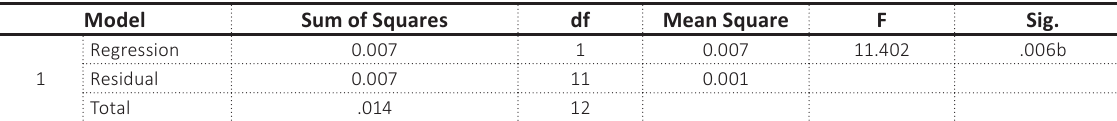
Table 6b. ANOVA result for hypothesis three Model